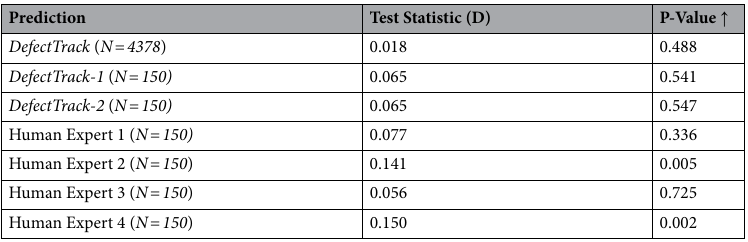
Table 3. Kolmogorov–Smirnov test results for comparing the defect cluster lifetime distribution predicted by DefectTrack and human experts measurements with the ground truth. N is the sample size, i.e., the total number of tracked defect clusters. DefectTrack‑1 and DefectTrack‑2 are results of the Kolmogorov–Smirnov test performed by random sampling of 150 defect clusters from the total predicted by DefectTrack